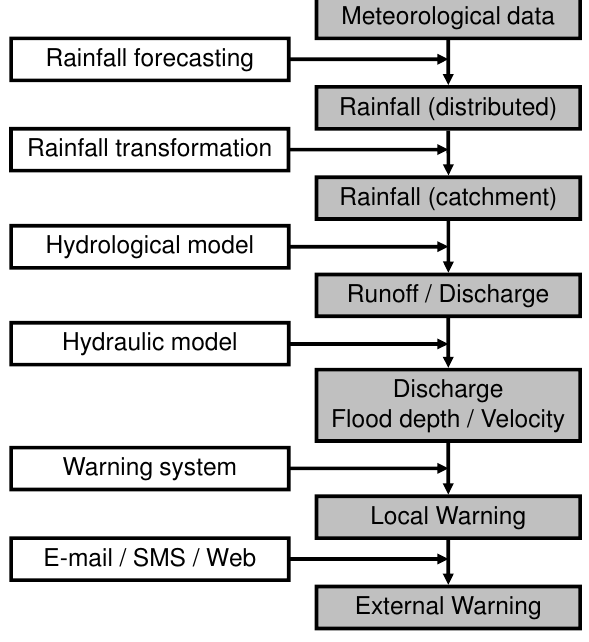
Fig. 5. The chain of components that forms the early warning sys-